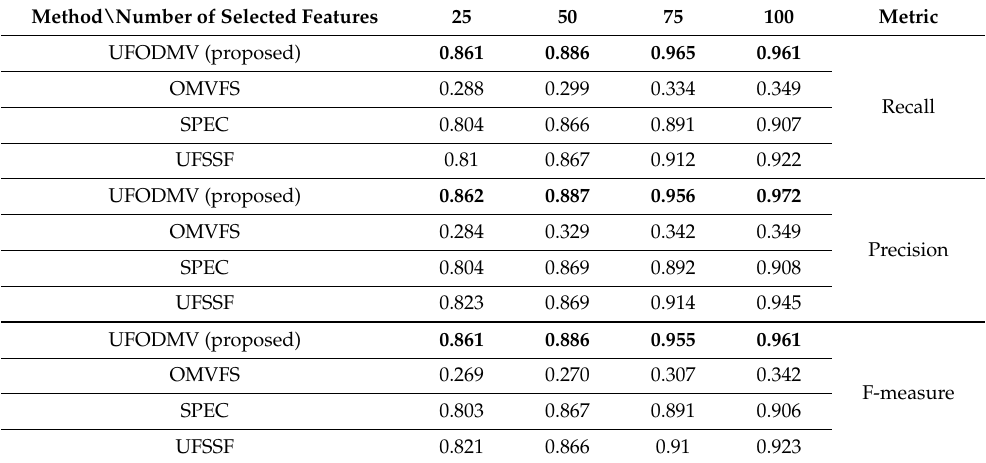
Table 3. Classification accuracy using Handwritten dataset with naive Bayes. Method\Number of Selected Features